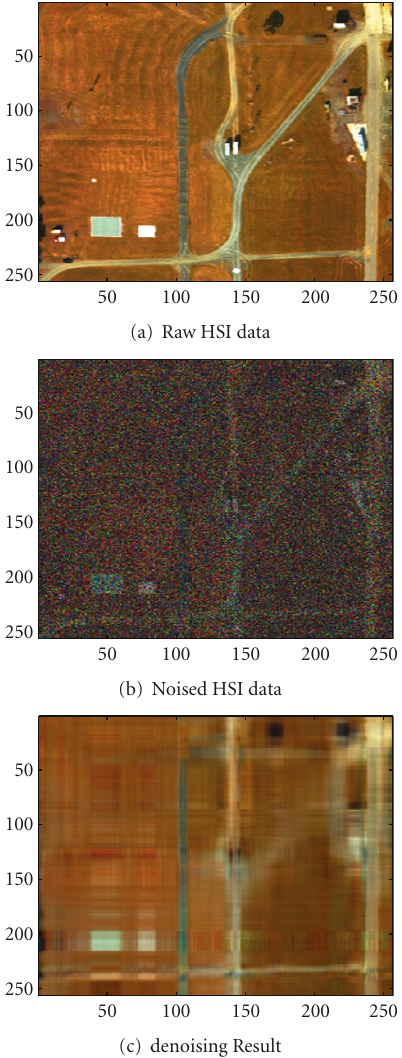
Figure 4: HSI image: results obtained by lower-rank tensor approximation using LRFP, LRTA, MWFP, or